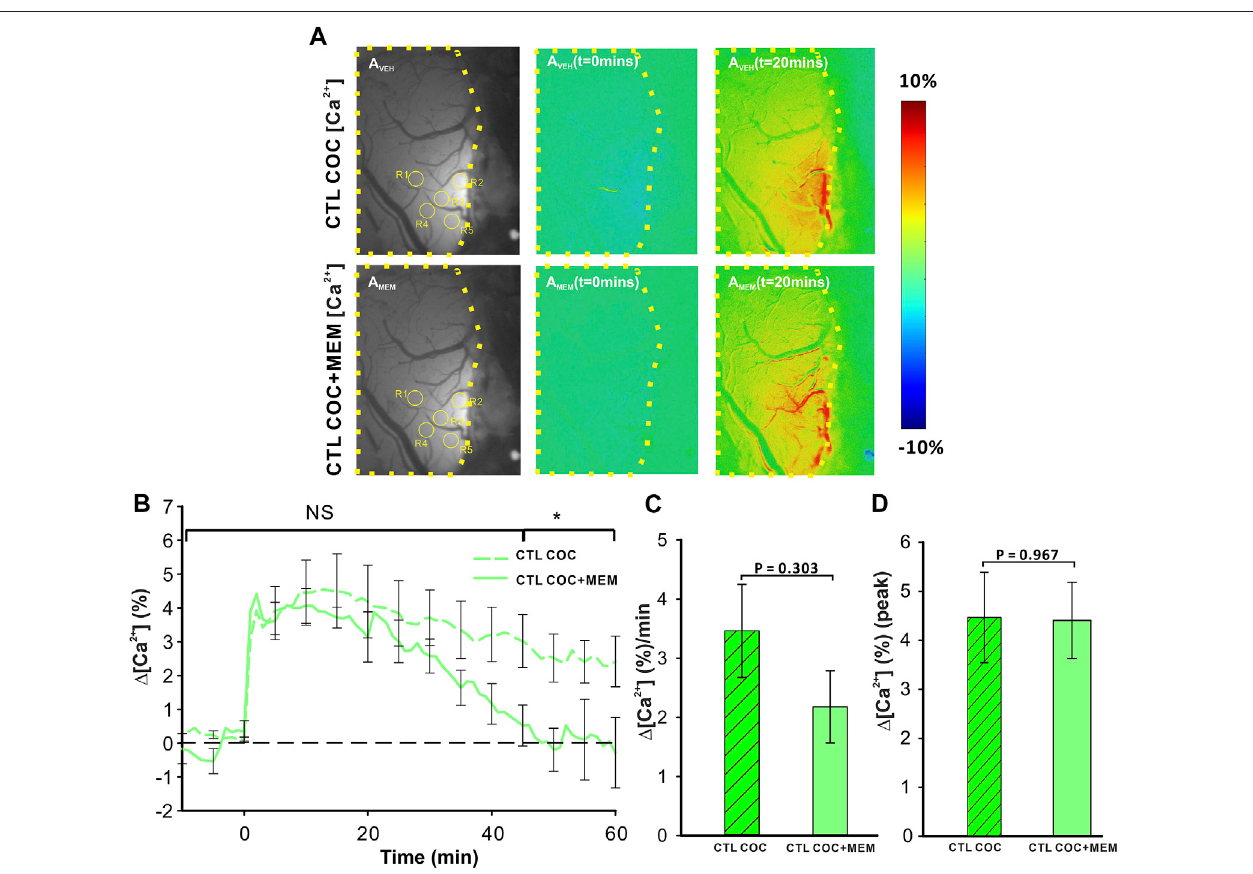
FIGURE 3 | NMDA antagonist (memantine) shortens the duration of [Ca 2+ ] i in fl ux in control animals. (A) Representative images demonstrating the [Ca 2+ ] i fl uorescence changesin PFCfollowing cocaine administration (1 mg/kg,i.v.)in vehicle pretreatment(upper panels) and memantine pretreatment (lowerpanel) rats at t= 20 min relative to the baseline (t = 0 min). Region of brain exposed through the cranial window outlined in yellow, with regions of interest (ROI) for quanti fi cation marked with yellow circles. (B) Time course of the mean cocaine-induced Δ [Ca 2+ ] i response revealing a reduction in the duration of the Ca 2+ in fl ux following memantine pretreatment. (C) Totalcocaine-inducedCa 2+ in fl uxwasreducedfollowingmemantine pretreatment. (D) ThepresenceofmemantinedidnotaffectthepeakCa 2+ in fl ux. Graphed values represent the mean and standard error. NS: not signi fi cant *: p < 0.05, signi fi cant